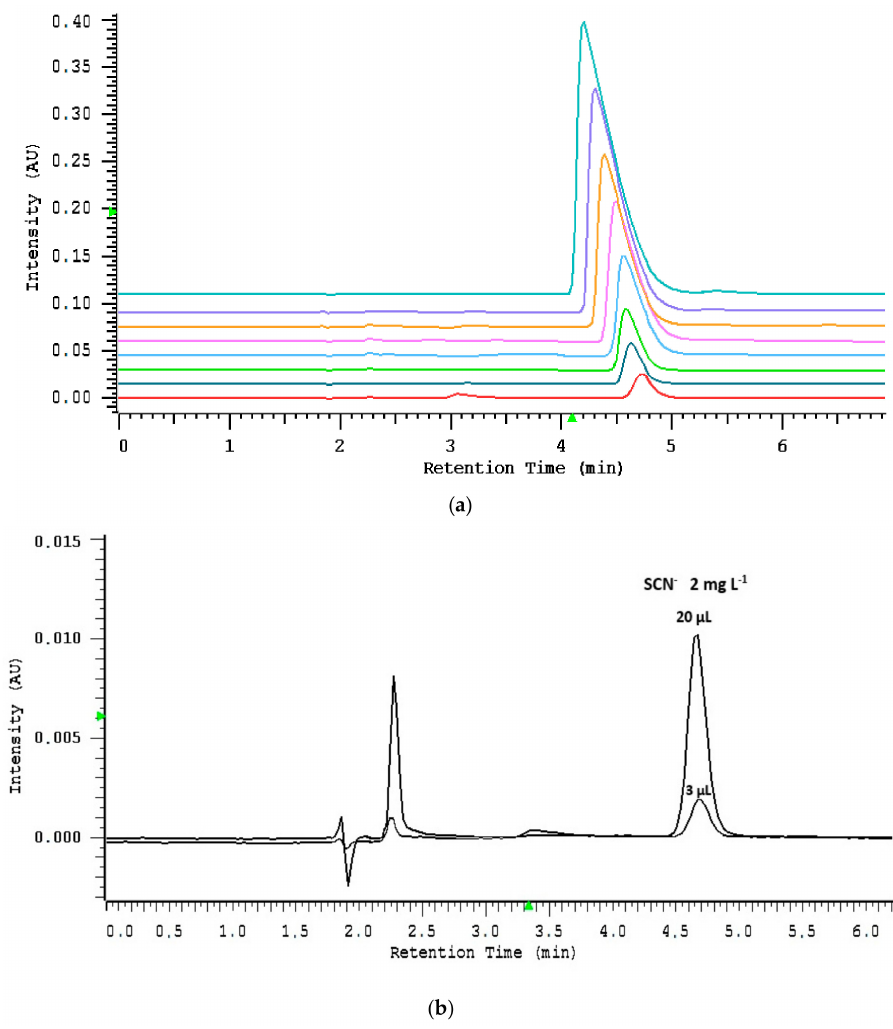
Figure 2. ( a ) Loadability study using a phosphatidylcholine column (IAM.PC.DD2 Regis HPLC) with total sample loads of 10; 15; 25; 50; 80; 100; 150; 200 mg L − 1 subsequently from the bottom to the top. Flow rate: 1 mL / min; detection: UV absorbance at 210 nm; injection volume: 10 µ L. ( b ) The column volume loadability. The first line represents an injection volume of 3 µ L, the second line refers to the volume of 20 µ L. The sample concentration is 2 mg L − 1